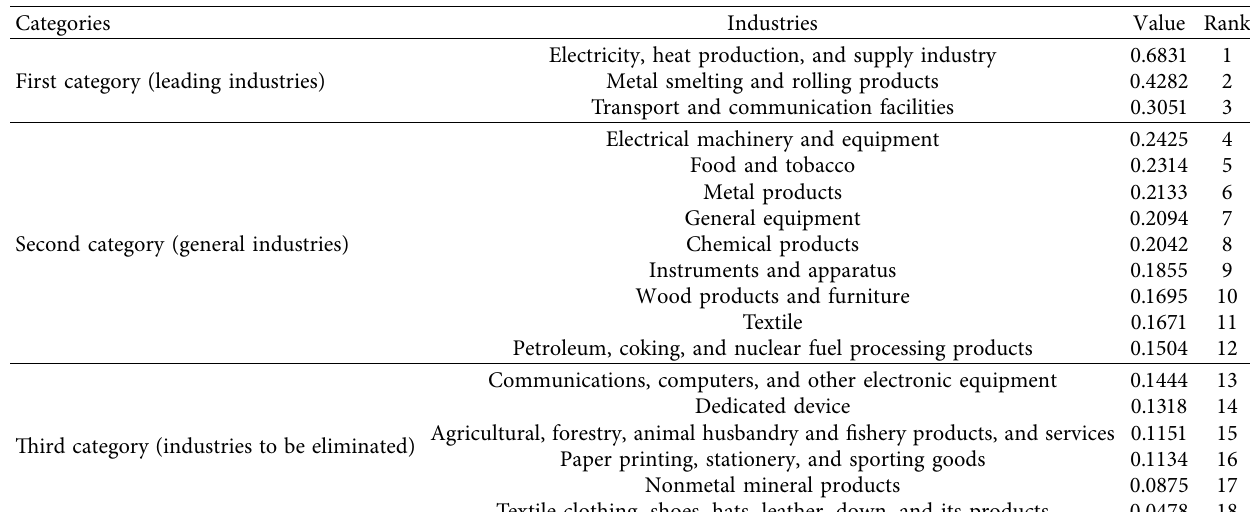
Table 1: Weights of the industries in Jinjiang City, Jiangsu